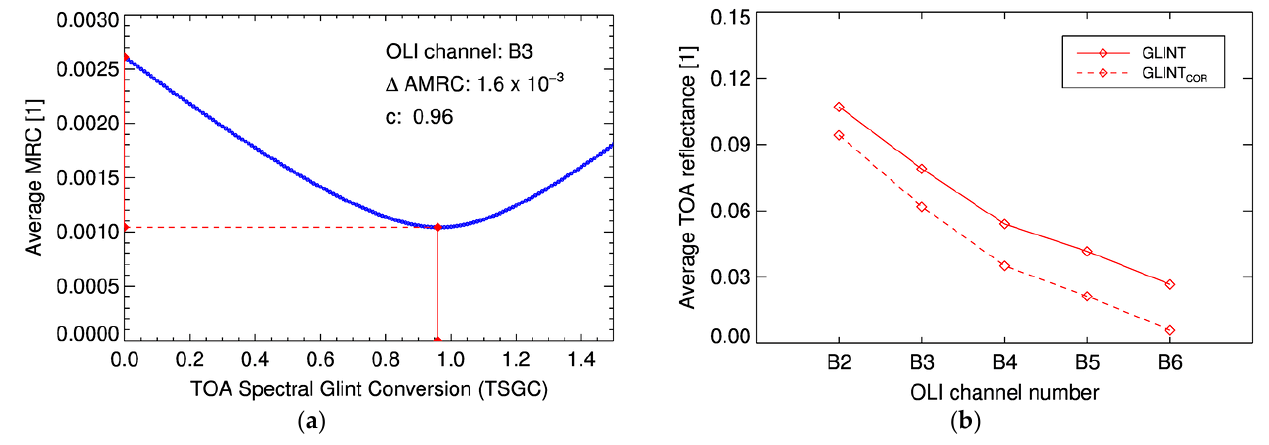
Figure 6. ( a ) Graphical representation of the minimization procedure to determine the TOA Spectral Glint Conversion (TSGC) at the example of OLI channel B3 for sample scene BRS-3; ( b ) Mean spec- tral TOA reflectance before and after glint correction. See text for further